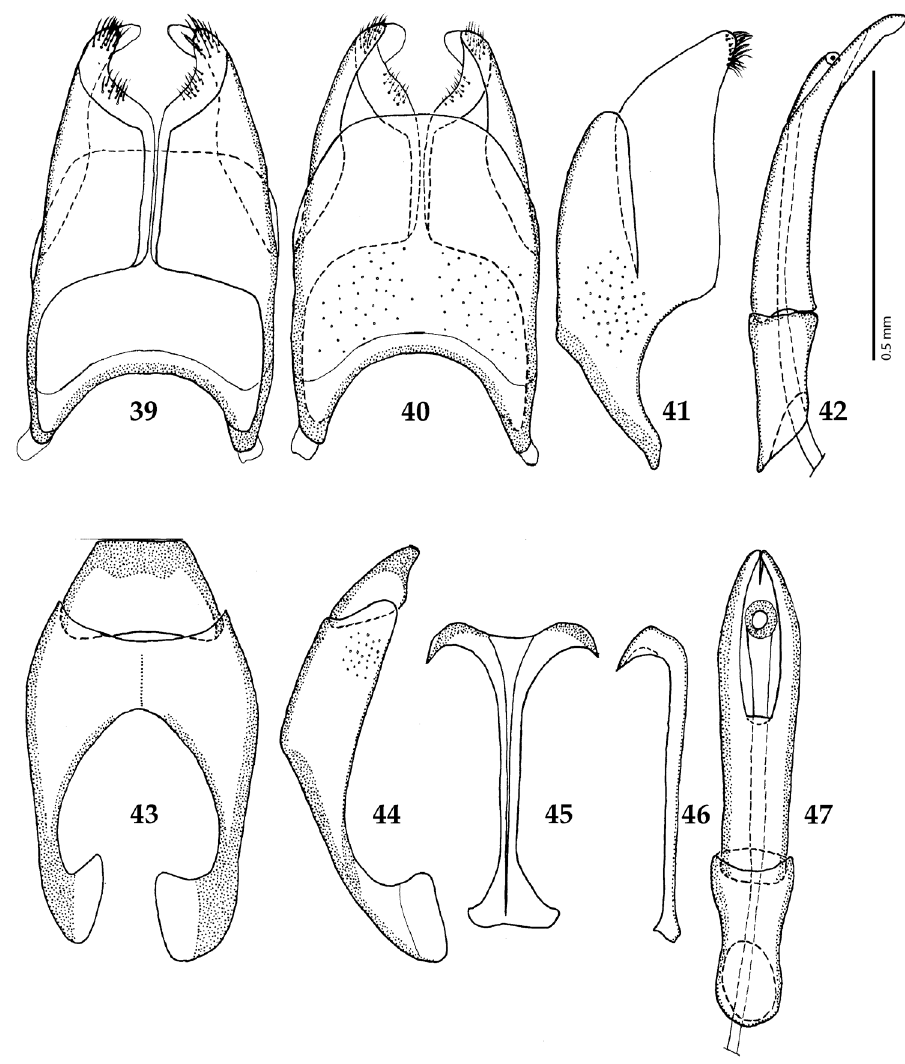
Figures 39–47. 39 Chalcionellus aeneovirens (Schmidt, 1890) male terminalia: 8 th sternite + 8 th tergite, ventral view 40 ditto, dorsal view 41 ditto, lateral view 42 male terminalia: aedeagus, lateral view 43 male terminalia: 9 th + 10 th tergites, dorsal view 44 ditto, lateral view 45 male terminalia: spiculum gastrale, ventral view 46 ditto, lateral view 47 male terminalia: aedeagus, dorsal view.